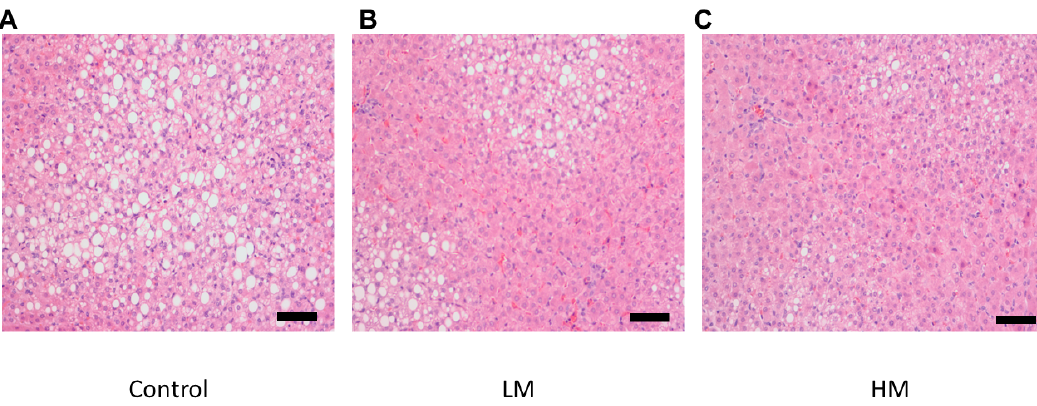
Figure 2. Histological images of hematoxylin and eosin (H&E) (200 × ) stained hepatic tissue for ( A ) Control, ( B ) Low Moringa (LM; 10%), and ( C ) High Moringa (HM; 15%). Scale bar = 100 µ m.